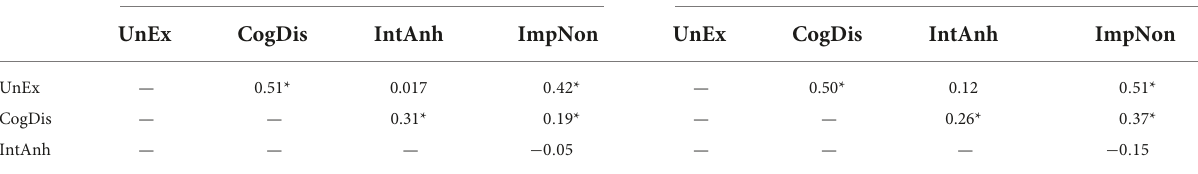
TABLE 2 Pearson correlations of the three dimensions on the Oxford-Liverpool Inventory of Feelings and Experiences (O-LIFE) included in the analyses. Experiment 1: geometric task Experiment 2: non-geometric